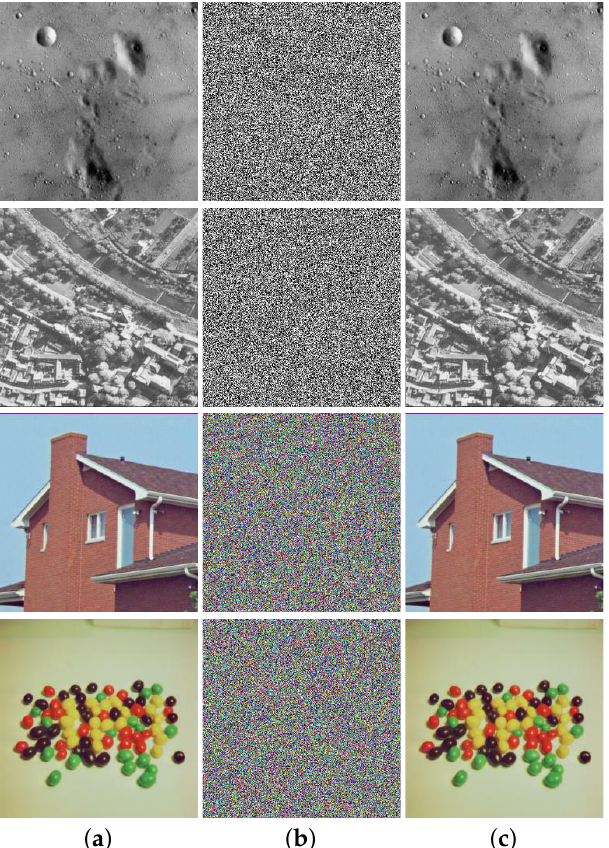
Figure 8. Results of visual effect test for IEA-IF-DLT: ( a ) plain images; ( b ) cipher images; ( c ) de- crypted